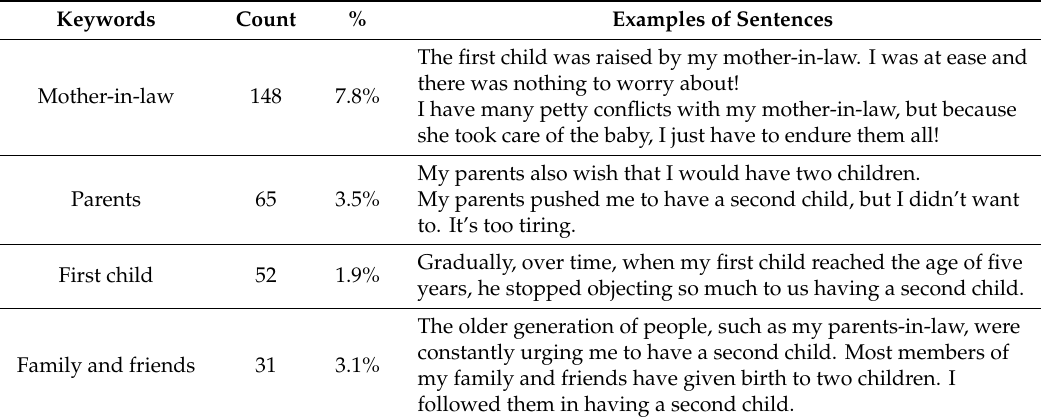
Table 6. Keywords indicating external factors and sentence